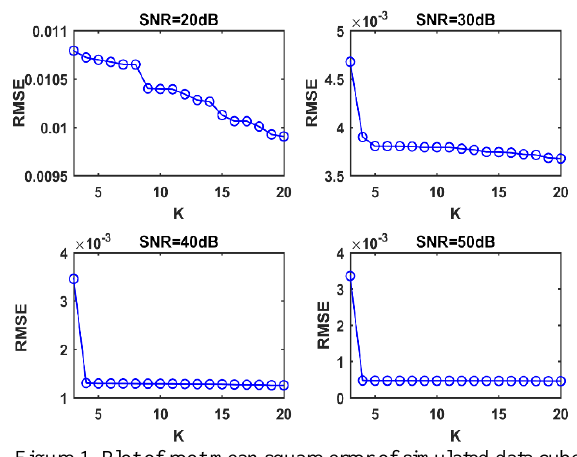
Figure 1. Plot of root mean square error of simulated data cube 1 as a function of the number of eigenvectors.